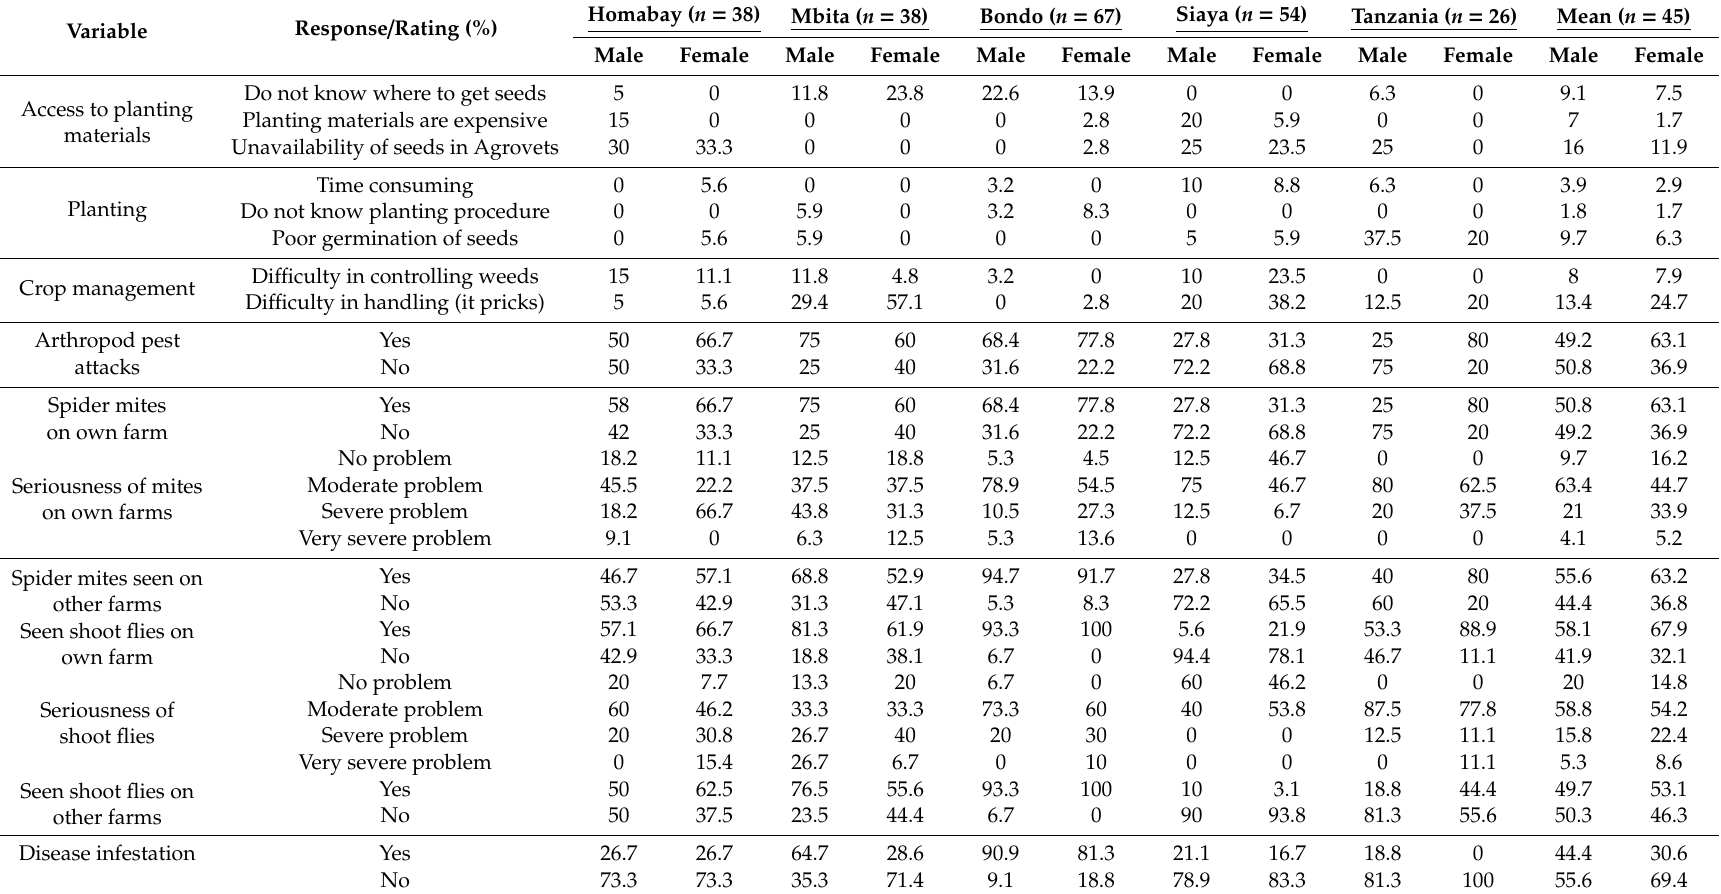
Table 2. Perception on brachiaria production challenges disaggregated by